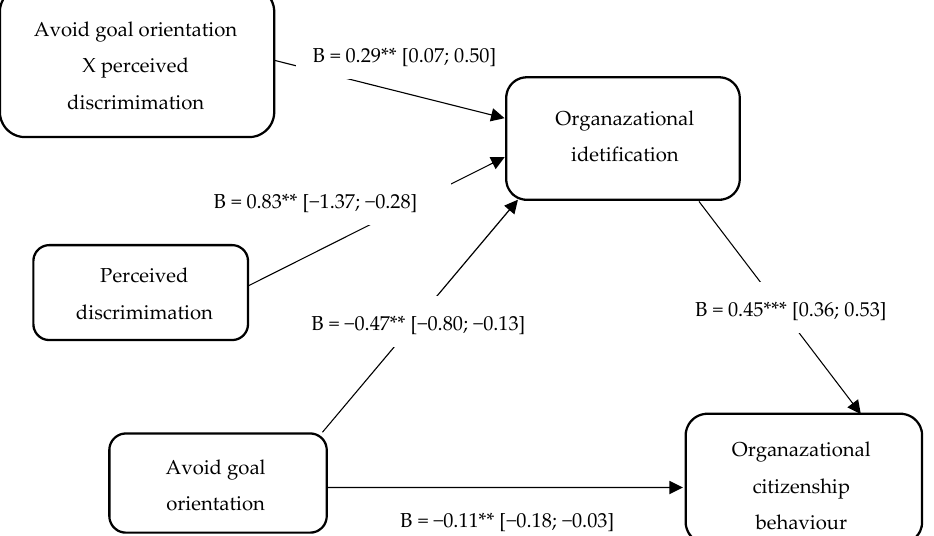
Figure 2. Results of the moderated mediation analysis. The relationship between performance-avoid goal orientation and OCB through organizational identification was moderated by perceived